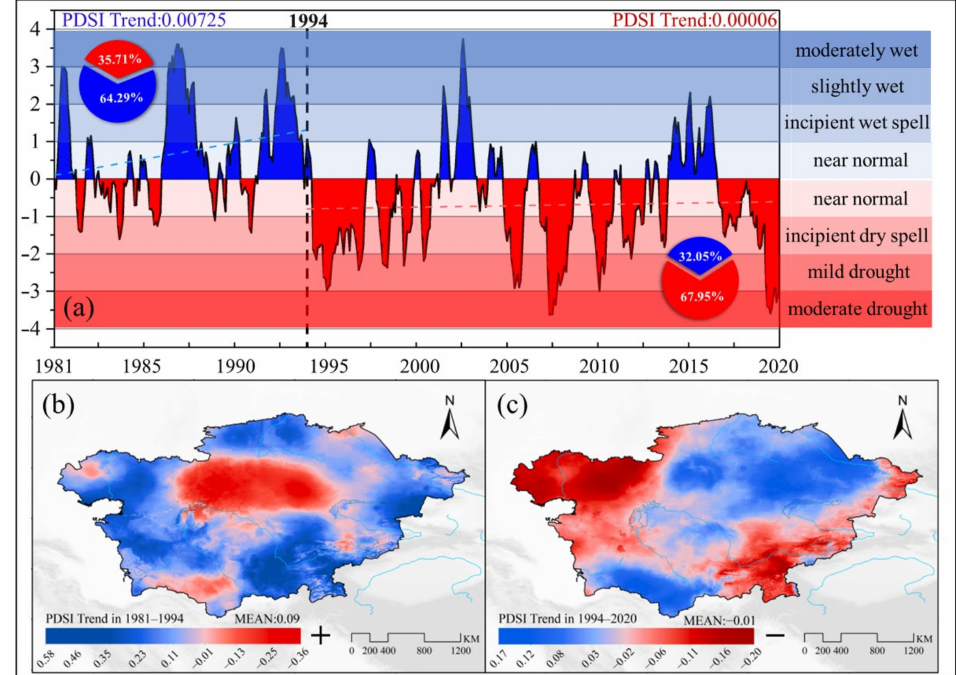
Figure 9. Dynamic characteristics and temporal and spatial trends of PDSI in Central Asia: ( a ) monthly average dry and wet shade anomalies of PDSI from 1981 to 2020; ( b , c ) PDSI trends before and after 1994,